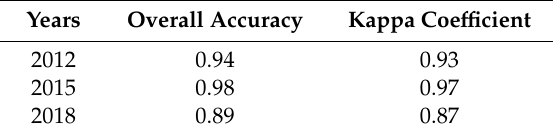
Figure 2. Land cover maps of Vilankulo for the years 2012 (upper left), 2015 (upper right), and 2018 (lower left). CCNV—close canopy natural vegetation; OCNV—open canopy natural vegetation; WB—water bodies; AGR—agriculture; BS—bare soils; GR—grassland. Table 7. Overall accuracy and Kappa coefficient.